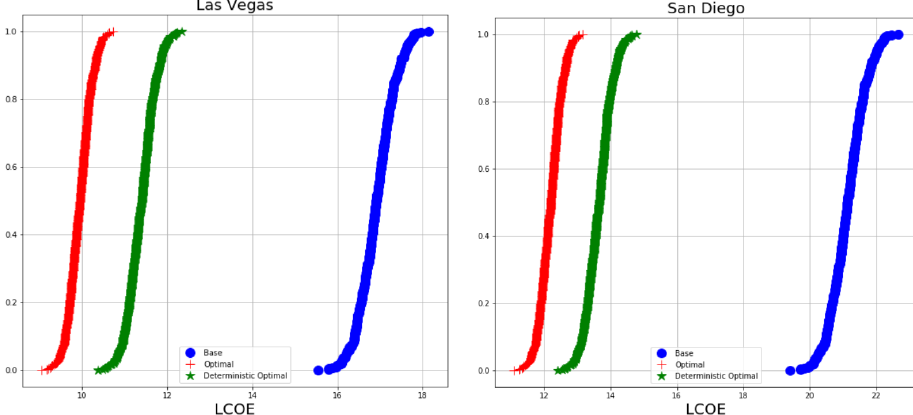
Figure 9. Comparing the CDF of LCOE at the base, deterministic optimal, and stochastic optimal for Las Vegas and San Diego.